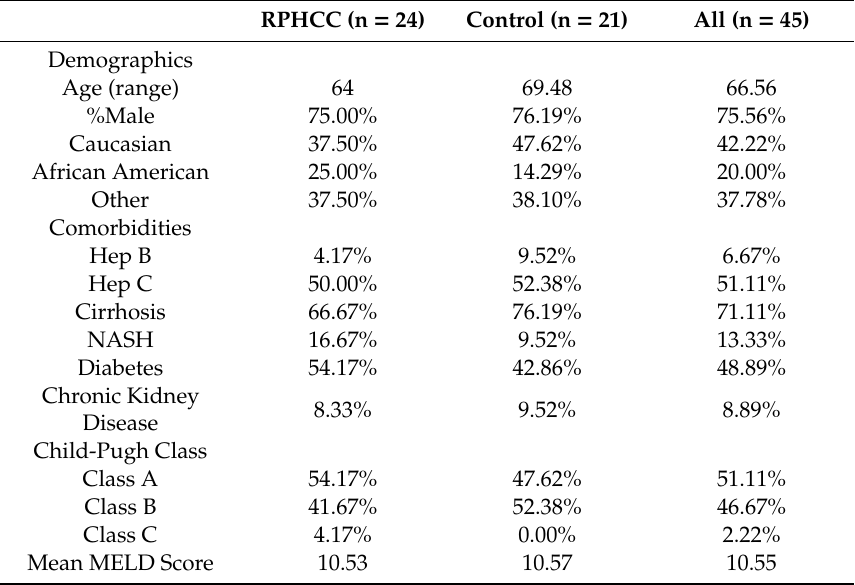
Table 1. Demographic data, comorbidities, Child-Pugh Class, and mean MELD score. None of the factors reached statistical significance between RPHCC and control tumors at p <